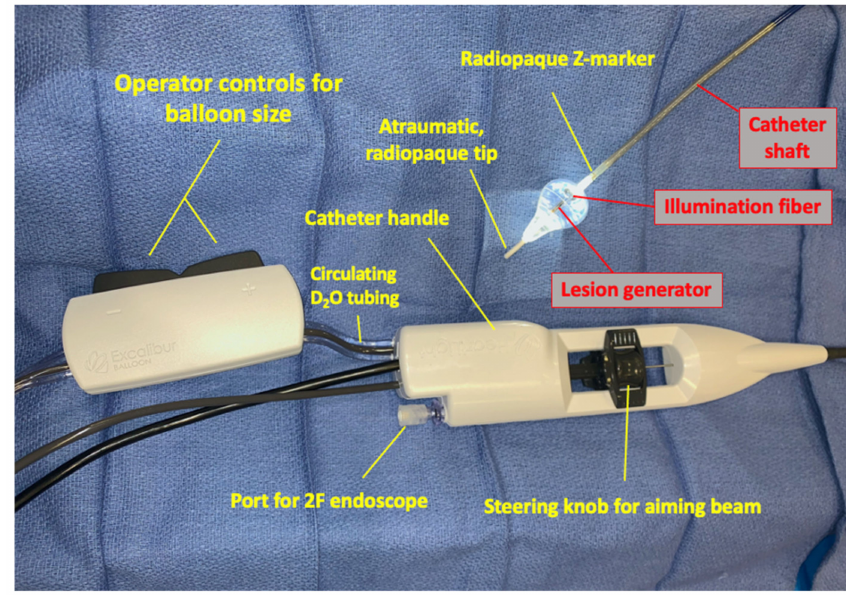
Figure 1. Components of HeartLight X3 3rd-generation laser ablation system